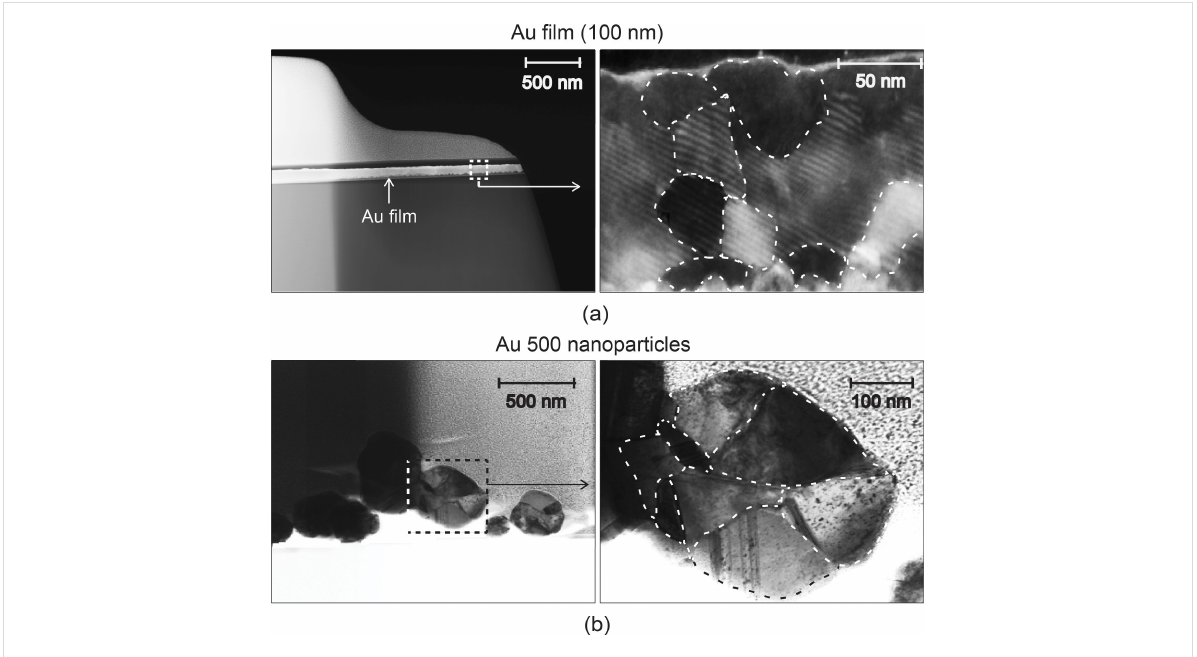
Figure 5: TEM images showing (a) Au film (100 nm) (left) with a magnified view of the section highlighted by the dashed lines shown on the right. In the magnified view, the dashed lines are used to highlight the grains within the film which have an average diameter of 40 ± 9 nm, and (b) several Au 500 nanoparticles (left) with a magnified view of a single nanoparticle with the grains highlighted by the dashed lines (right). The average grain diam- eter was found to be 96 ± 30